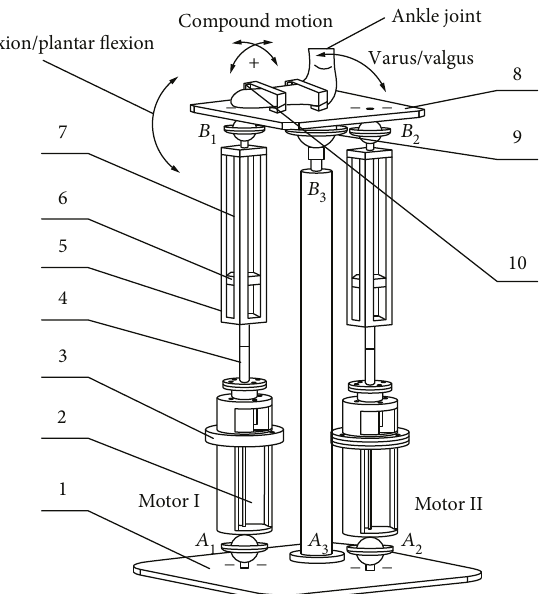
Figure 3: The structural model of the robot: (1) lower platform, (2) motor, (3) U-shaped connector, (4) screw rod, (5) guide frame, (6) slider block, (7) spring, (8) upper platform, (9) ball pin structure, and (10) foot